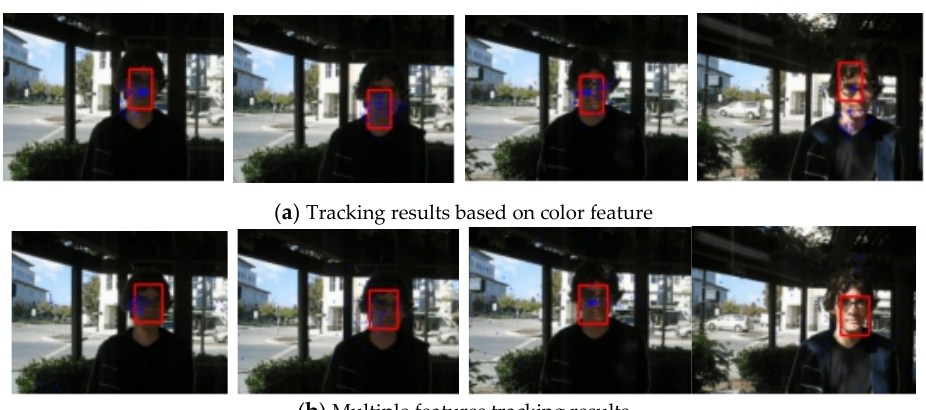
Figure 2. Tracking results under the illumination variation.